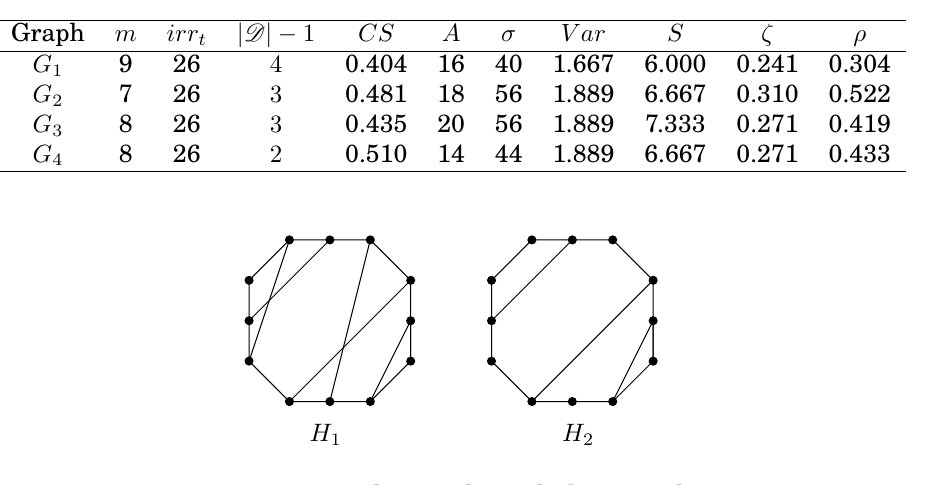
Figure 1: Two nonregular graphs with the same degree set.